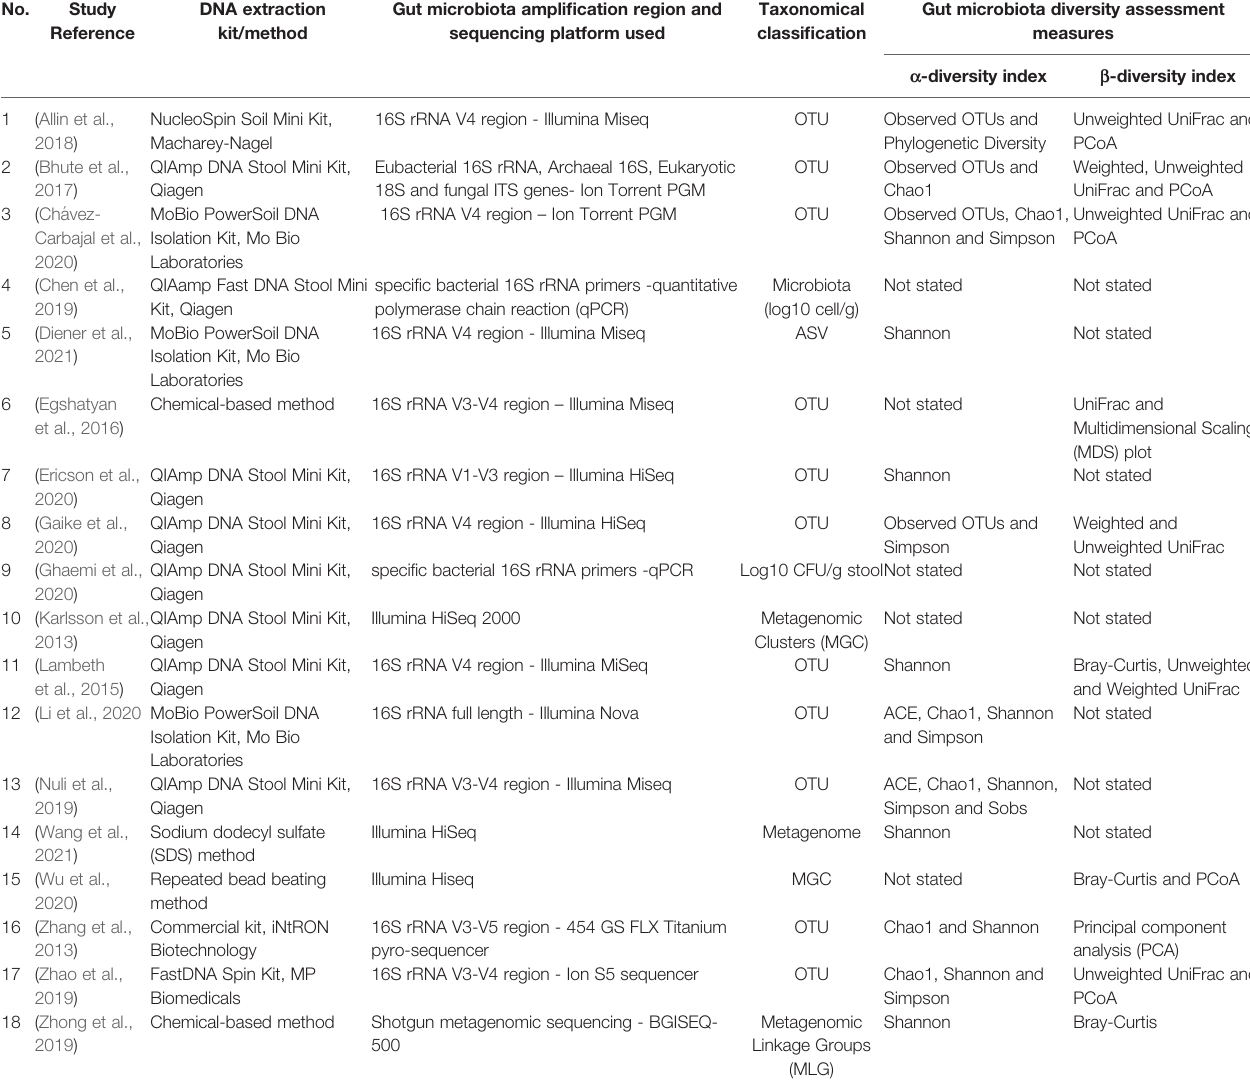
TABLE 3 | Characteristics of the methodology used by the 18 selected articles for gut microbiota composition and diversity assessments.